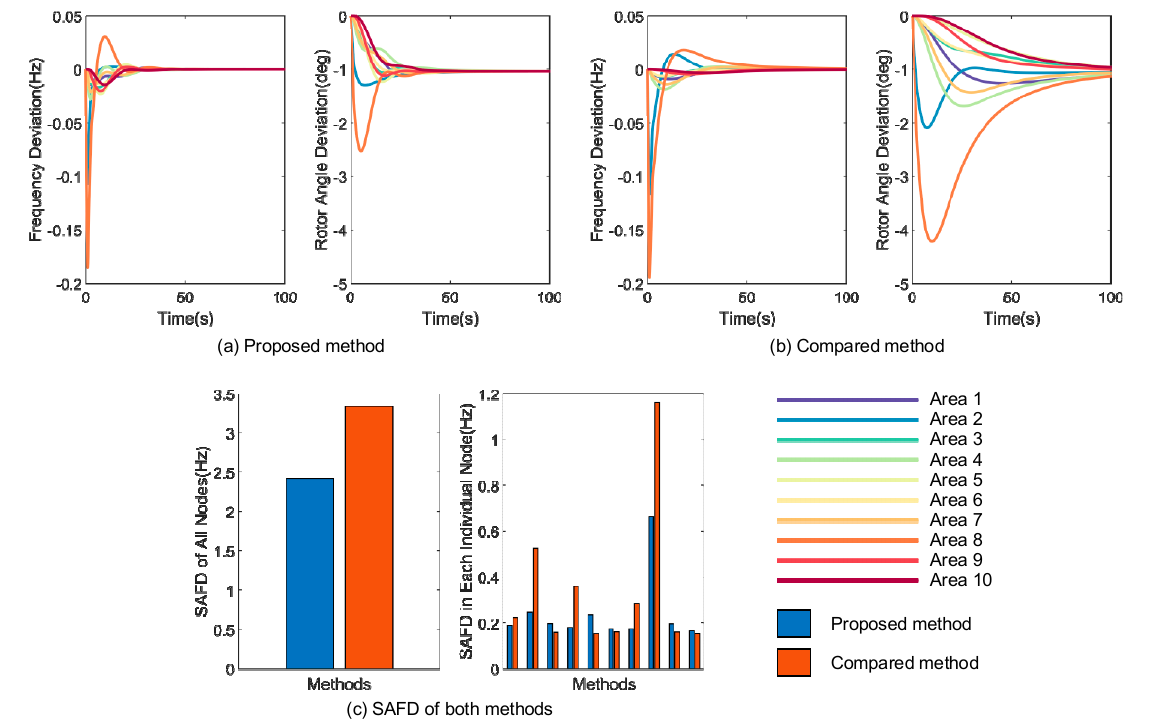
Figure 9. Frequency deviation, rotor angle deviation and sum of absolute frequency deviation (SAFD) of both methods in the frequency event C.